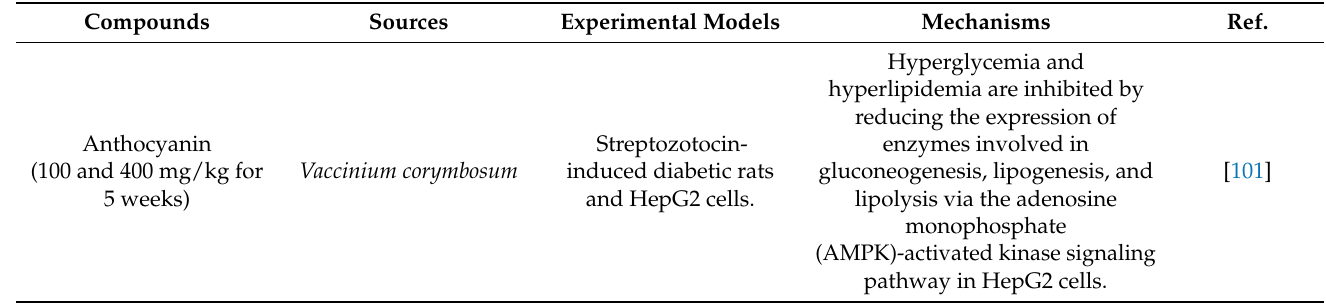
Table 1. Antioxidant signaling pathways of natural